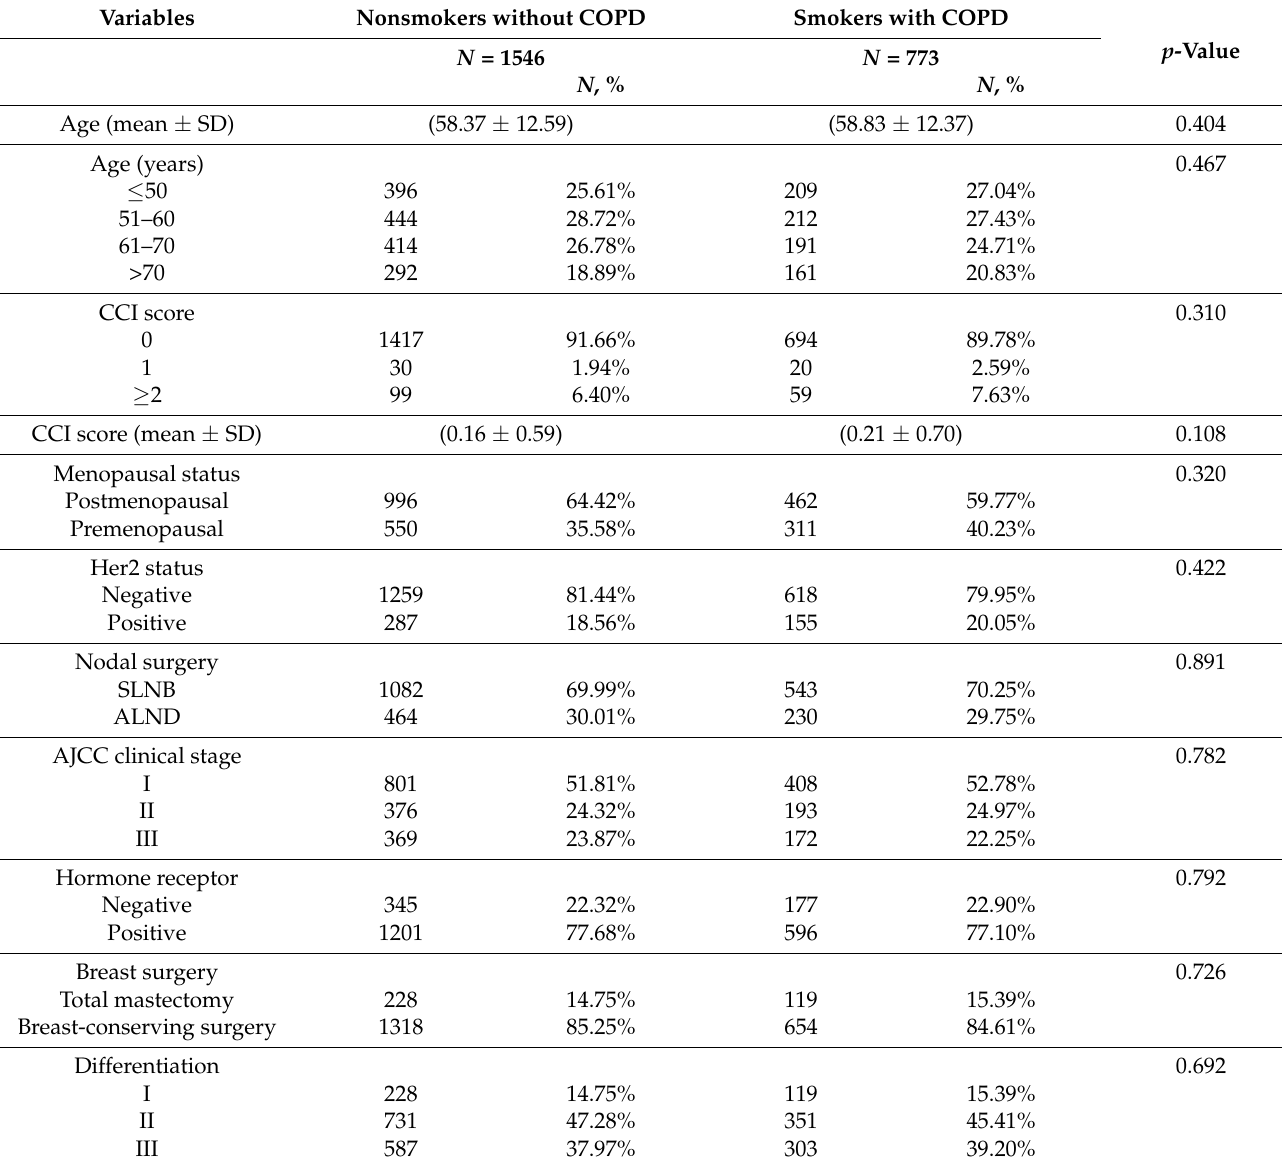
Table 1. Characteristics of patients with invasive ductal carcinoma with or without smoking-related COPD before breast surgery after propensity score